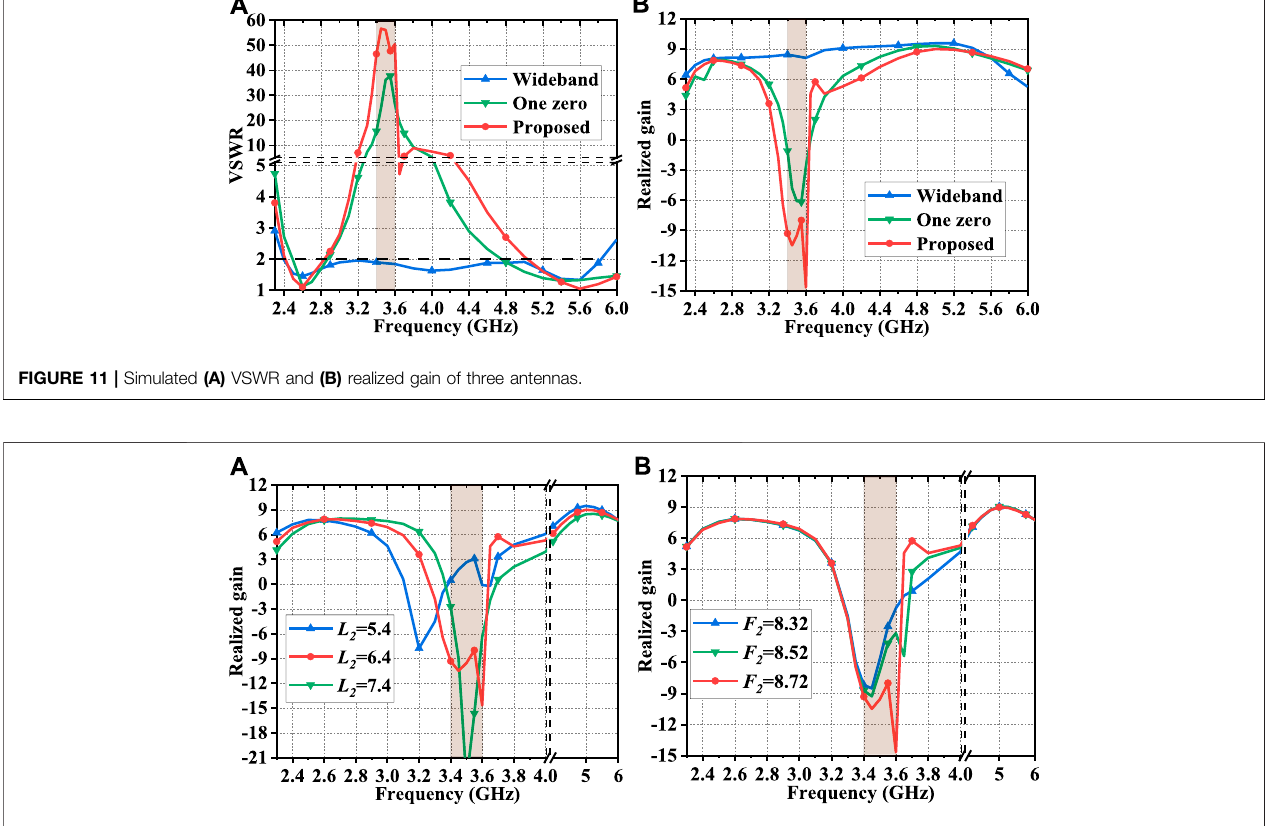
FIGURE 12 | Impacts of (A) L 2 and (B) F 2 on realized